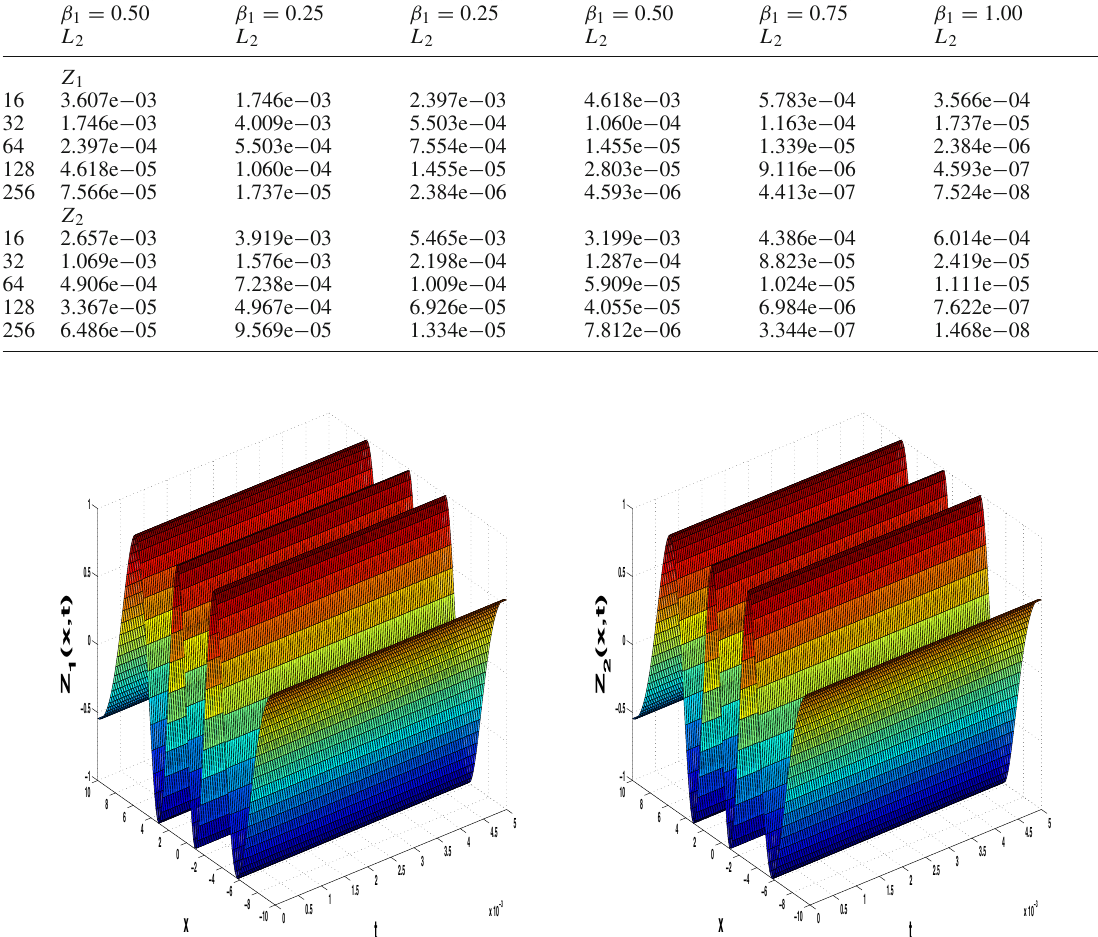
Table 1 Numerical solutions of proposed method at time T = 0 . 005 with different α 1 β 1 and grids points M for example 1 M α 1 = 0 . 25 , β